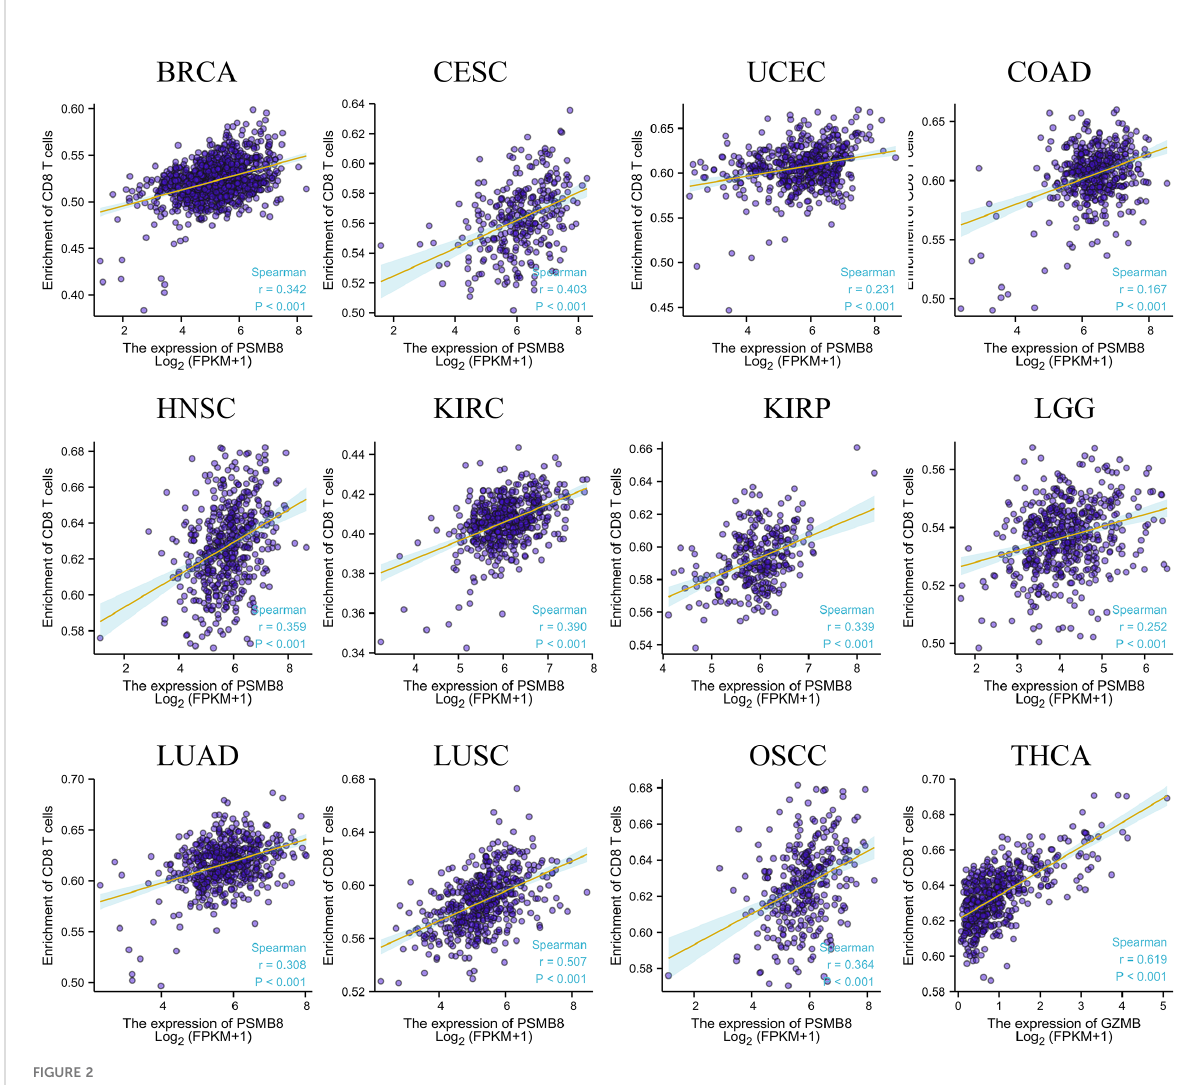
FIGURE 2 Correlation between PSMB8 expression and CD8 + T cells in different